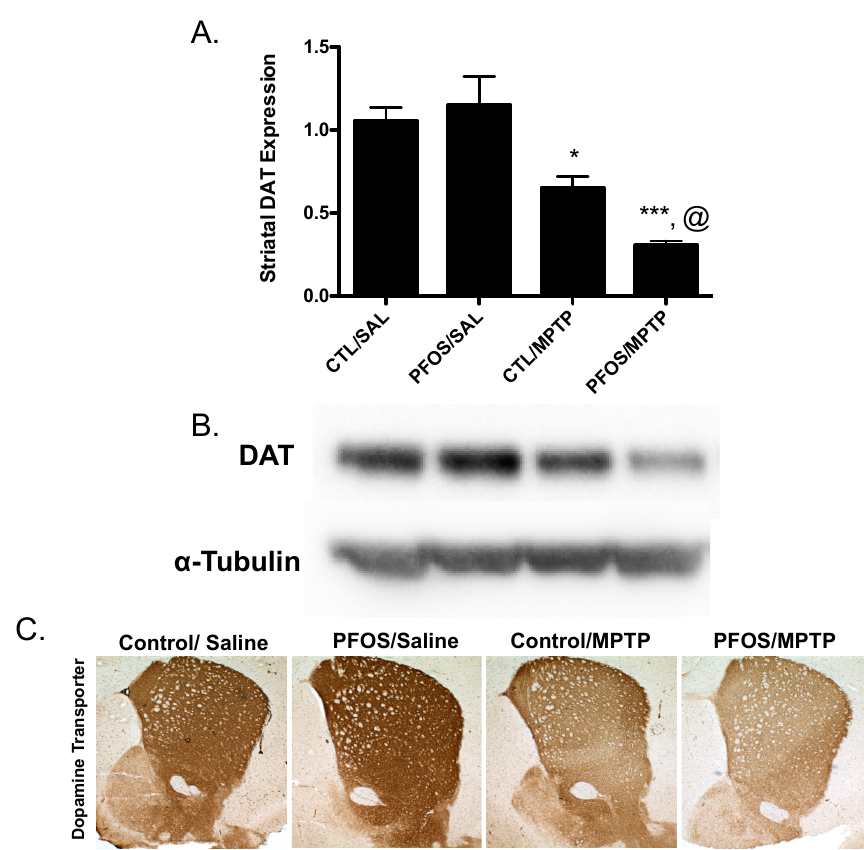
Figure 4. Challenge with the dopamine neurotoxin, MPTP, causes significant reductions in DAT expression following PFOS treatment. An additional cohort of nine-week-old C57BL/6J male mice were exposed to 10 mg/kg PFOS for 14 days. One day following the last PFOS exposure, mice were injected with saline or 10 mg/kg MPTP at 7:00 a.m. and 7:00 p.m. and then allowed to sit for seven days before analysis. ( A ) Treatment with MPTP resulted in a significant reduction in the expression in striatal DAT in control animals that did not receive PFOS. Moreover, treatment with MPTP exacerbated reductions in striatal DAT in animals that had received PFOS prior to MPTP treatment; ( B ) and ( C ) are representative immunoblot and immunohistochemical processing, respectively, demonstrating the reductions in DAT expression in the striatum of treated animals. α‐ Tubulin was included to ensure even protein loading. Columns represent means of raw data + SEM (six mice per treatment group). * Values statistically significant from CTL/SAL ( p < 0.05). *** Values statistically significant from PFOS/SAL ( p < 0.001). @ Values statistically significant from CTL/MPTP (p < 0.01)